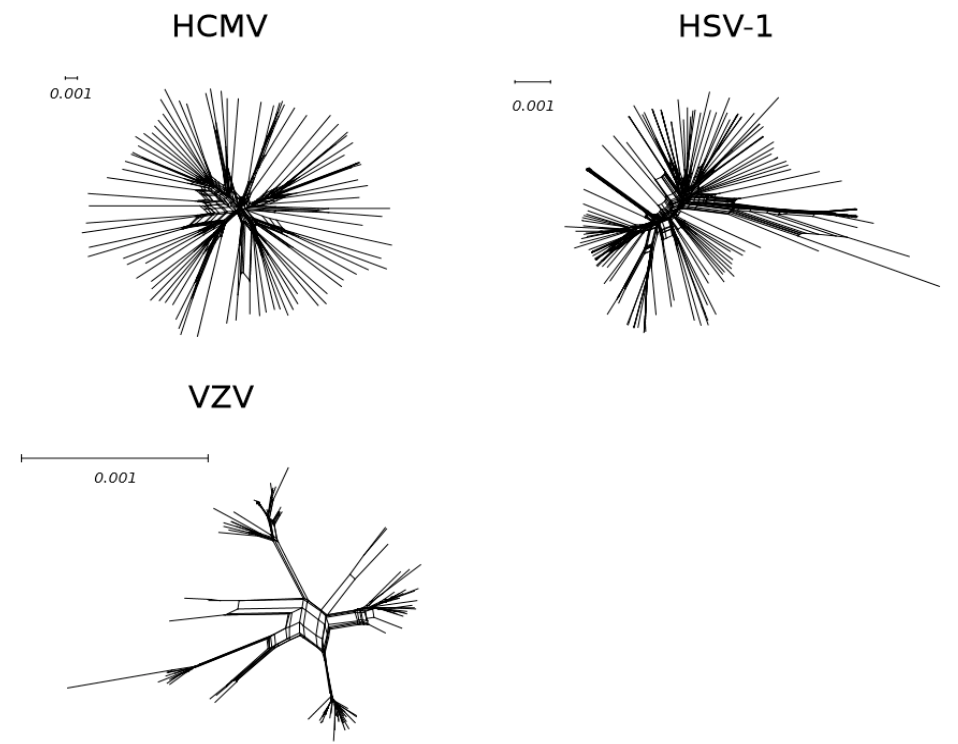
Figure 2. Genetic diversity of human herpesviruses. Neighbor–net split networks of 84 unpassaged HCMV (Supplementary Table S1), 140 HSV–1 [79], and 110 VZV [80] genomes. A phylogenetic network is a graph to visualize the evolutionary relationships (edges) among taxa (nodes). In particular, a split network represents incompatibilities within a data set by combining the results of di ff erent phylogenetic trees. Neighbor–net split networks of all whole genome sequences were constructed with SplitsTree v4.13.1 [81] using uncorrected p–distances and all polymorphic sites, after removing gap